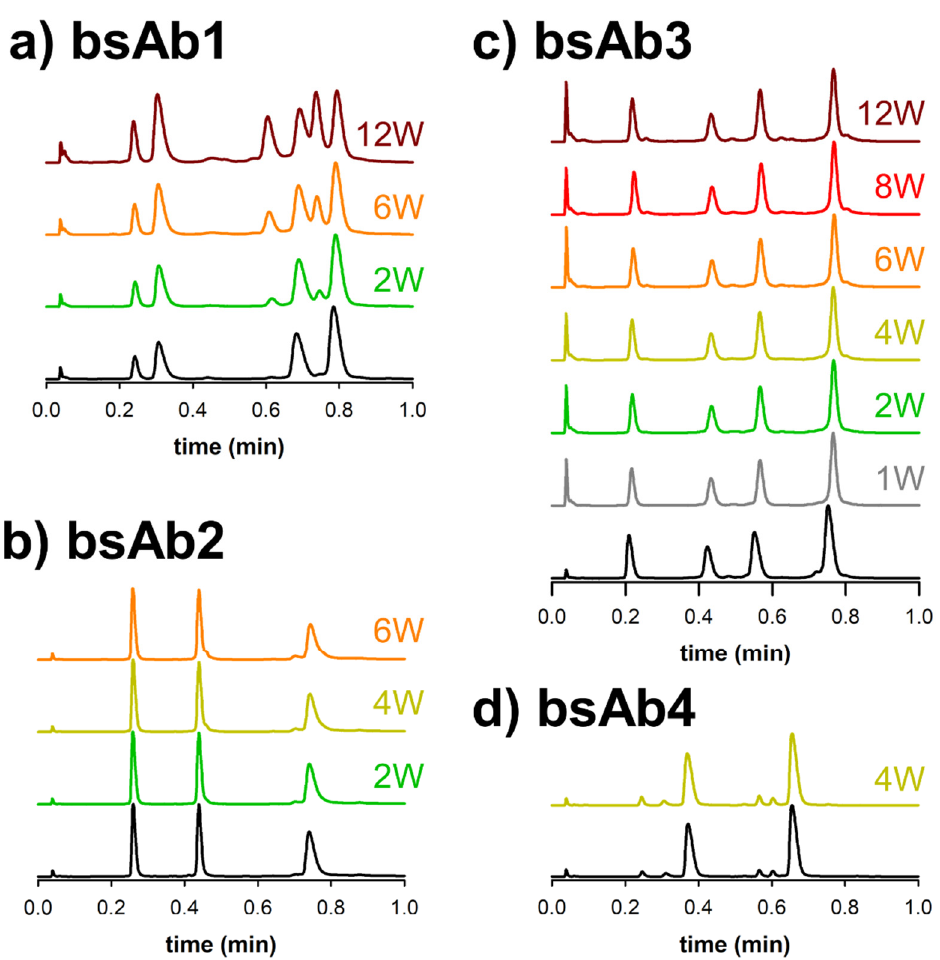
Figure 3. RPLC-Fluorescence chromatograms of the different bispecific antibodies (bsAbs), namely bsAb1 ( a ), bsAb2 ( b ), bsAb3 ( c ), and bsAb4 ( d ) acquired before (black) and after a thermal stress performed at 40 °C for 1 (grey), 2 (green), 4 (lime), 6 (orange), 8 (red), or 12 (brown) weeks.